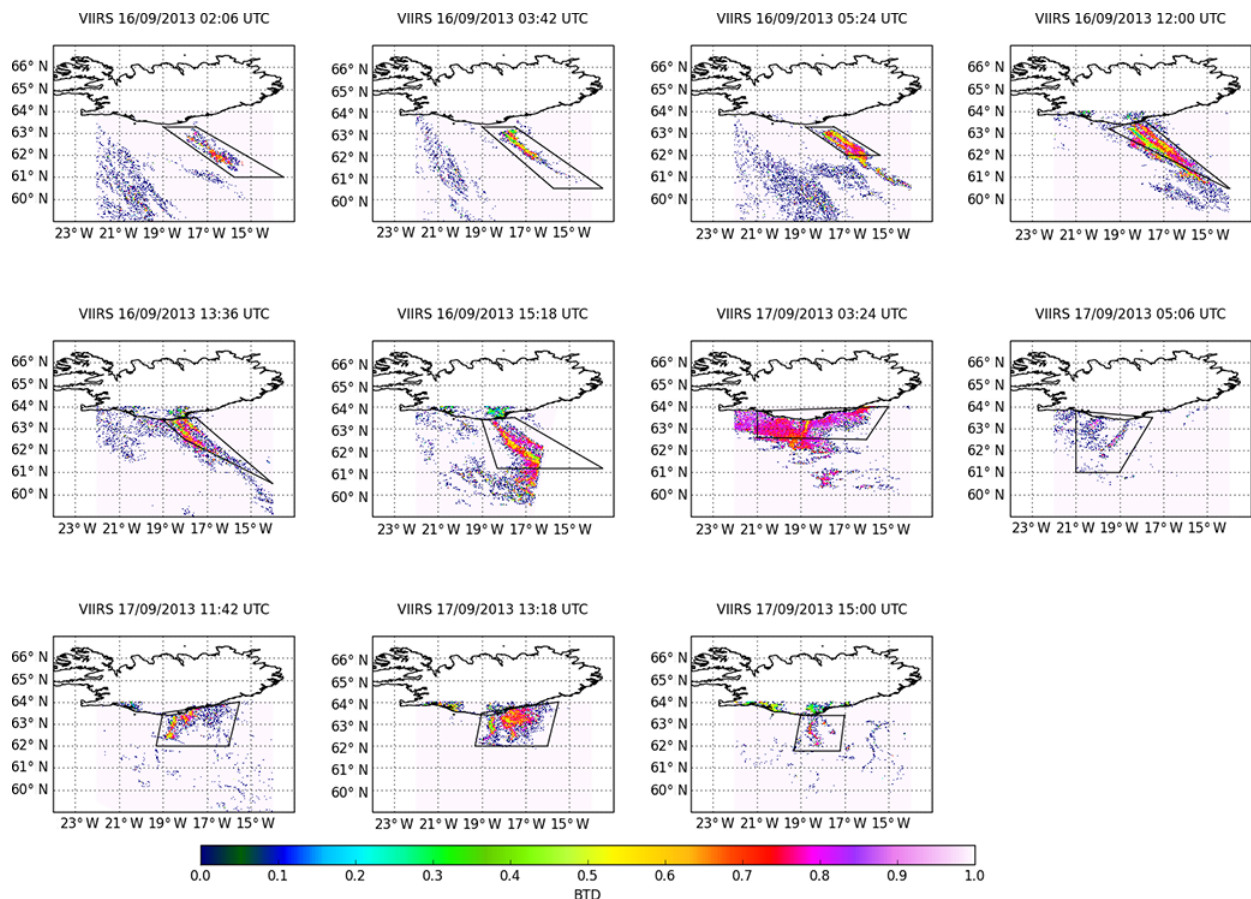
Figure 9. VIIRS BTDs for pixels identified as resuspended ash, 16–17 September